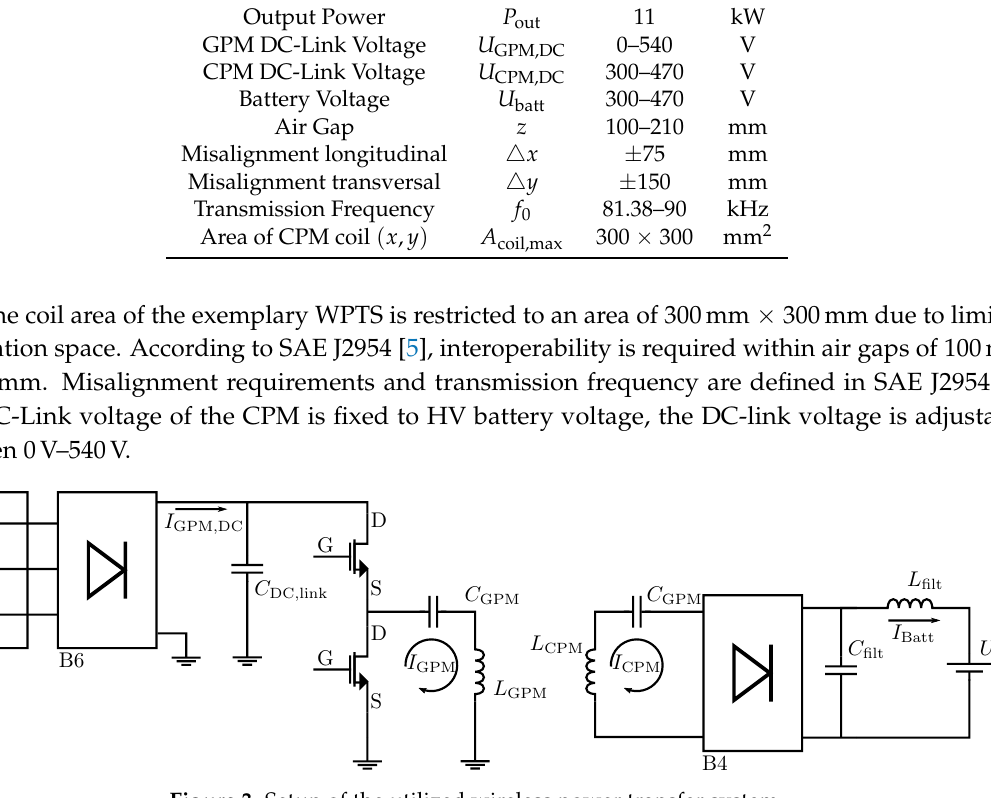
Figure 3. Setup of the utilized wireless power transfer